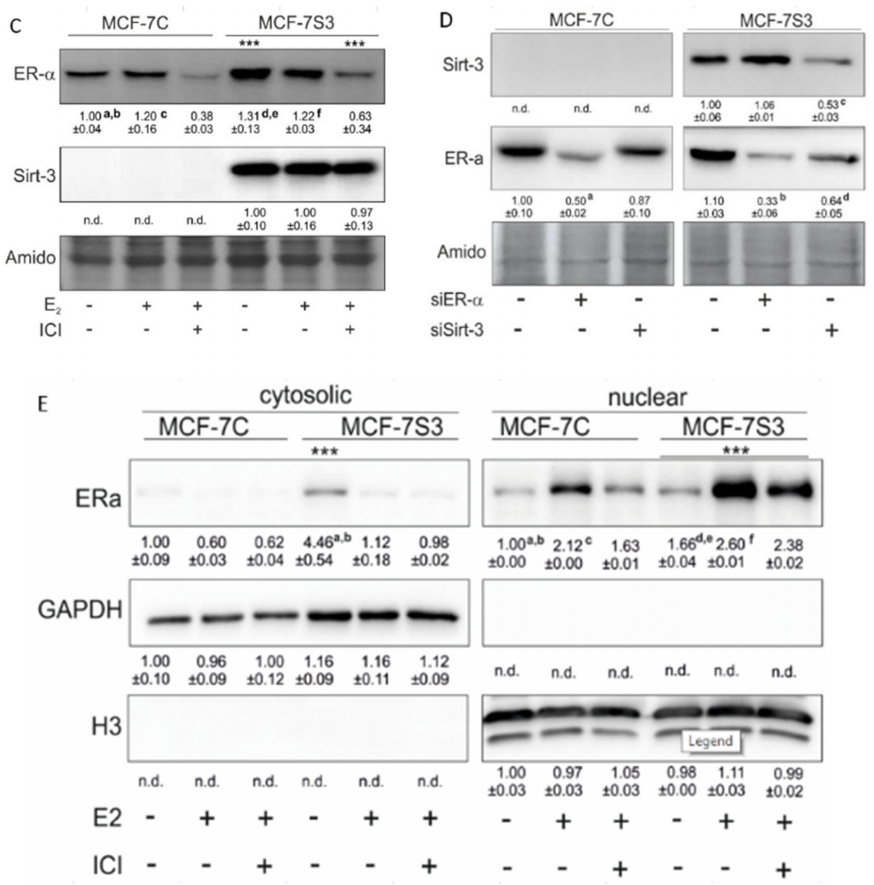
Figure 1. Sirt3 regulates ER α expression and localization. ( A ) Expression of sirt-3 gene was significantly increased in MCF-7S3 clones as compared with MCF-7C (*** p < 0.001). The results are presented as fold change ± SE on a log-scale, normalized to the control MCF-7C. Experiments were repeated at least three times (hereafter referred to as n ≥ 3); ( B ) Expression of esr-1 gene was significantly increased in the control and E2 + ICI-treated MCF-7S3 clones as compared with MCF-7C (* p < 0.05); ( C ) Immunoblots of ER α and Sirt3 protein expression level. Two-way ANOVA revealed significant interaction e ff ect between Sirt3 and treatment on ER α F (2,12) = 9.321, p = 0.004, partial η 2 = 0.608; higher in the control (*** p < 0.001) and E2 + ICI-treated (*** p < 0.001) MCF-7S3 vs. MCF-7C. In MCF-7C, higher in E2 vs. the control ( a p < 0.01) and E2 + ICI-treated ( c p < 0.001) and in the control vs. E2 + ICI-treated ( b p < 0.001). In MCF-7S3, higher in the control vs. E2 ( d p < 0.01) and E 2 + ICI-treated ( e p < 0.001) and in E2 vs. E 2 + ICI-treated ( f p < 0.001); ( D ) Immunoblots of ER α and Sirt3 protein expression level in the cells transfected with scrambled (siSCR) control or siER- α and siSirt3 RNA. Lower ER α in the siER- α -treated vs. siSCR MCF-7C cells ( a p < 0.05) and MCF-7S3 cells ( b p < 0.01). In MCF-7S3, lower Sirt3 ( c p < 0.05) and ER α ( d p < 0.01) in the siSirt3-treated cells; ( E ) Immunoblots of ER α protein expression in cellular fractions. For cytosolic fraction, two-way ANOVA revealed a significant interaction e ff ect between Sirt3 and treatment F (2,12) = 54.61, p < 0.001, partial η 2 = 0.948; higher cytosolic ER α in the control MCF-7S3 vs. MCF-7C (*** p < 0.001). In MCF-7S3, higher cytosolic ER α in the control vs. E2 ( a p < 0.001) and E2 + ICI-treated group ( b p < 0.001). For nuclear fraction, two-way ANOVA revealed significant interaction e ff ect between Sirt3 and treatment F (2,12) = 1054.57, p < 0.001, partial η 2 = 0.997; higher nuclear ER α in MCF-7S3 vs. MCF-7C (*** p < 0.001). In MCF-7C, lower nuclear ER α in the control vs. E2 ( a p < 0.001) and E2 + ICI-treated group ( b p < 0.001); higher nuclear ER α in E2 vs. E2 + ICI-treated group ( c p < 0.001). In MCF-7S3, lower nuclear ER α in the control vs. E2 ( d p < 0.001) and E2 + ICI-treated group ( e p < 0.001) and higher nuclear ER α in E2 vs. E2 + ICI-treated group ( f p < 0.001). For ( C ), ( D ) and ( E ) results are shown as a ratio of the mean ± SD normalized to the control MCF-7C ( n ≥ 3). Amidoblack was used as a loading